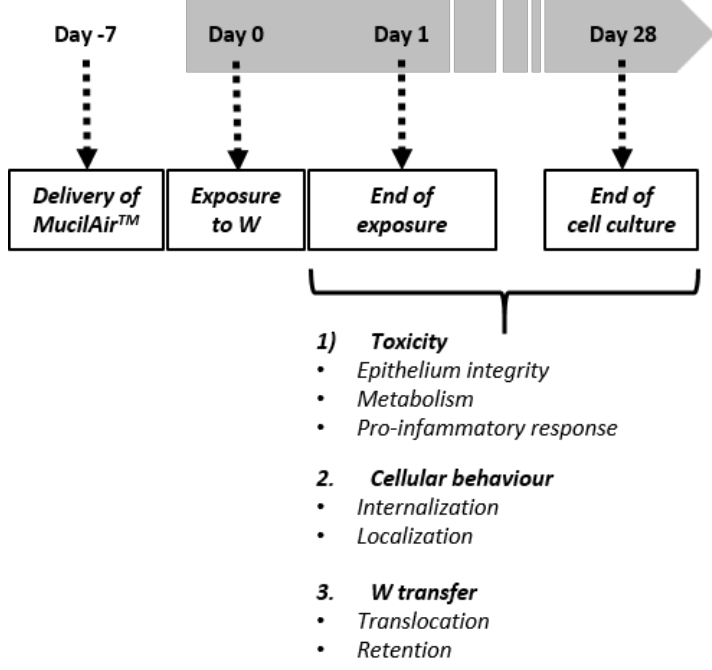
Figure 1. Experimental design. MucilAir™ was kept in culture for one week before exposure to tungsten nanoparticles (W-NPs), tungsten carbide cobalt particles alloy (WC-Co) and WO 42− . After treatment (24 h), uninternalized W was removed and cells were further cultured for 28 days. During this time several parameters were evaluated at regular intervals to monitor W toxicity, its internalization and intracellular localization, as well as its translocation from the apical to the basolateral